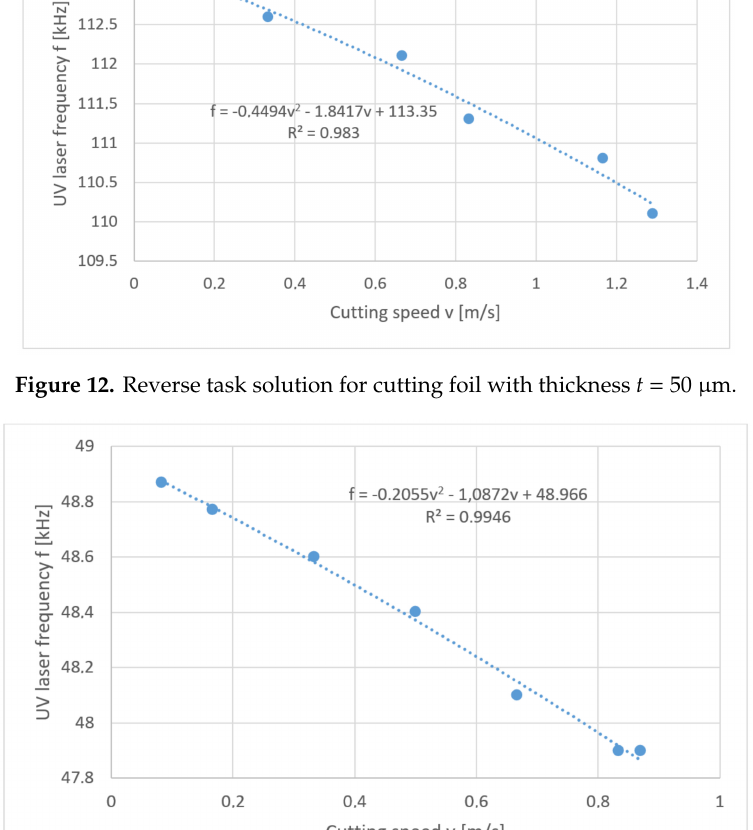
Figure 13. Reverse task solution for cutting foil with thickness t = 60 µ